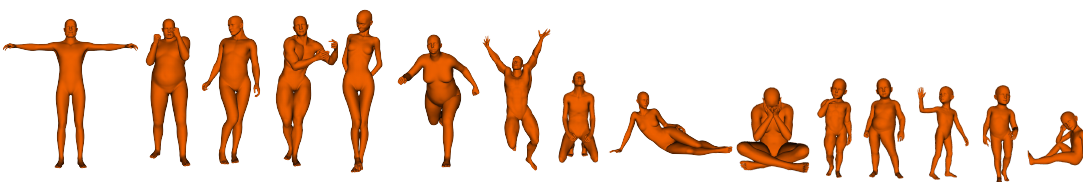
Figure 8. Fifteen representative human poses with different subjects in the SHREC-SY dataset [1].